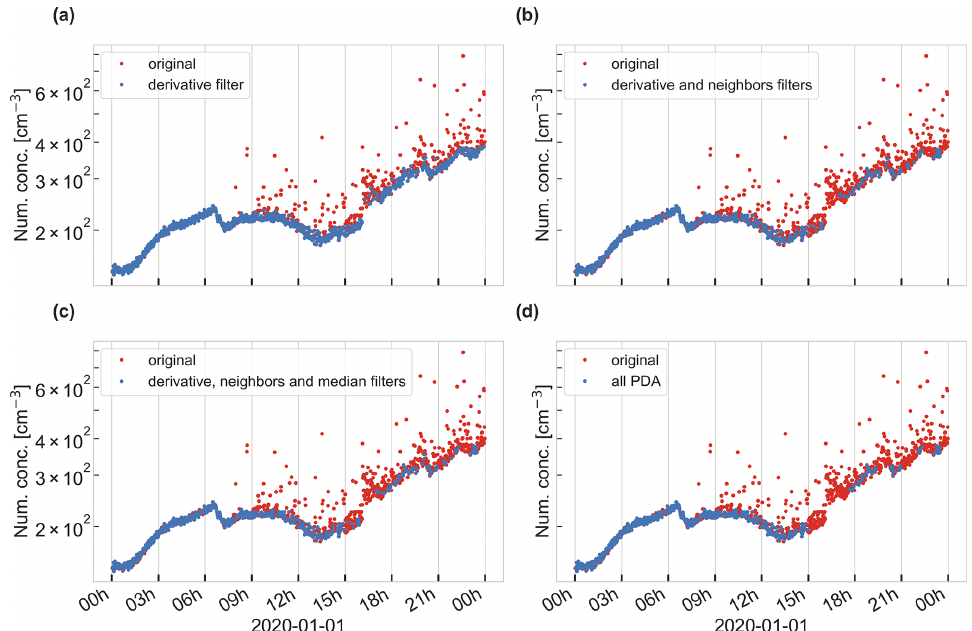
Figure A12. Same as Fig. A11 but with slightly stricter coefficients of the derivative filter. We chose a derivative filter with a = 0 . 45 and m = 0 . 5 to flag more data points in this case